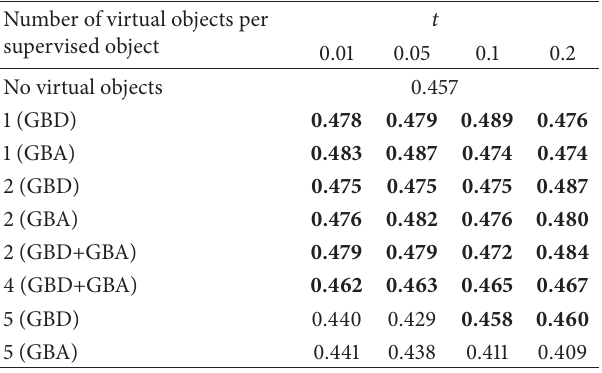
Table 10: Comparison of classification ability of each class,